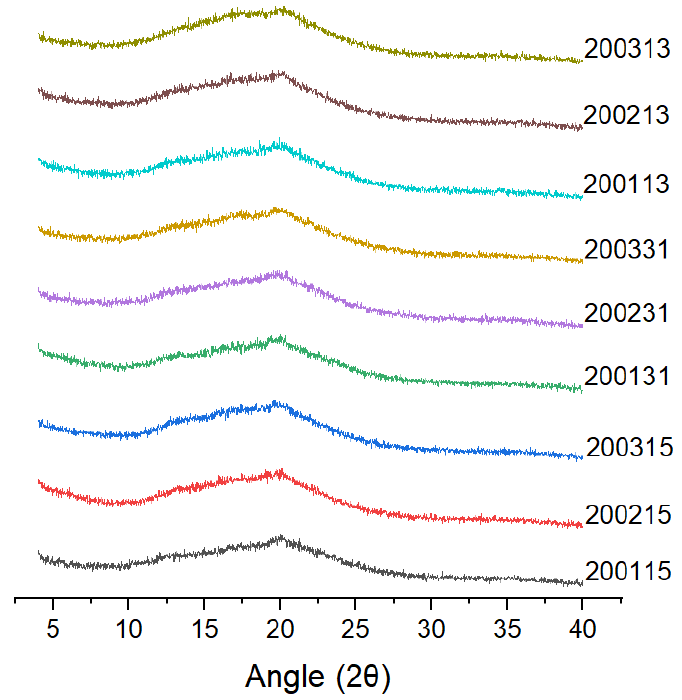
Figure 3. X − ray diffraction patterns of the recombinant flours. Figure 3. X-ray diffraction patterns of the recombinant flours. In the FTIR spectrum, the peak at 1538 cm − 1 was correlated with the presence of starch-protein complex, the peaks at 1714 cm − 1 and 2854 cm − 1 indicated the existence of lipid-starch complex, and the simultaneous appearance of the three peaks indicated the presence of starch-lipid-protein complexes in the samples [34]. As shown in Figure 4, all the cooked recombinant flours showed peaks with different intensities at 1538 cm − 1 , indicating the formation of starch-protein complexes. No obvious peak was observed at 2854 cm − 1 and 1745 cm − 1 , which possibly indicated that the low content of lipid in wheat flour and the further lipid loss during separating of gluten proteins and starch reduced the possibility for forming starch-lipid or starch-lipid-protein complexes. Compared with other flours, more obvious peaks at 1538 cm − 1 were observed in 200115, 200215, 200315, 200113, and 200231, in view of their lower LMP contents (Table 2), we proposed that more starch-protein complexes were formed in these